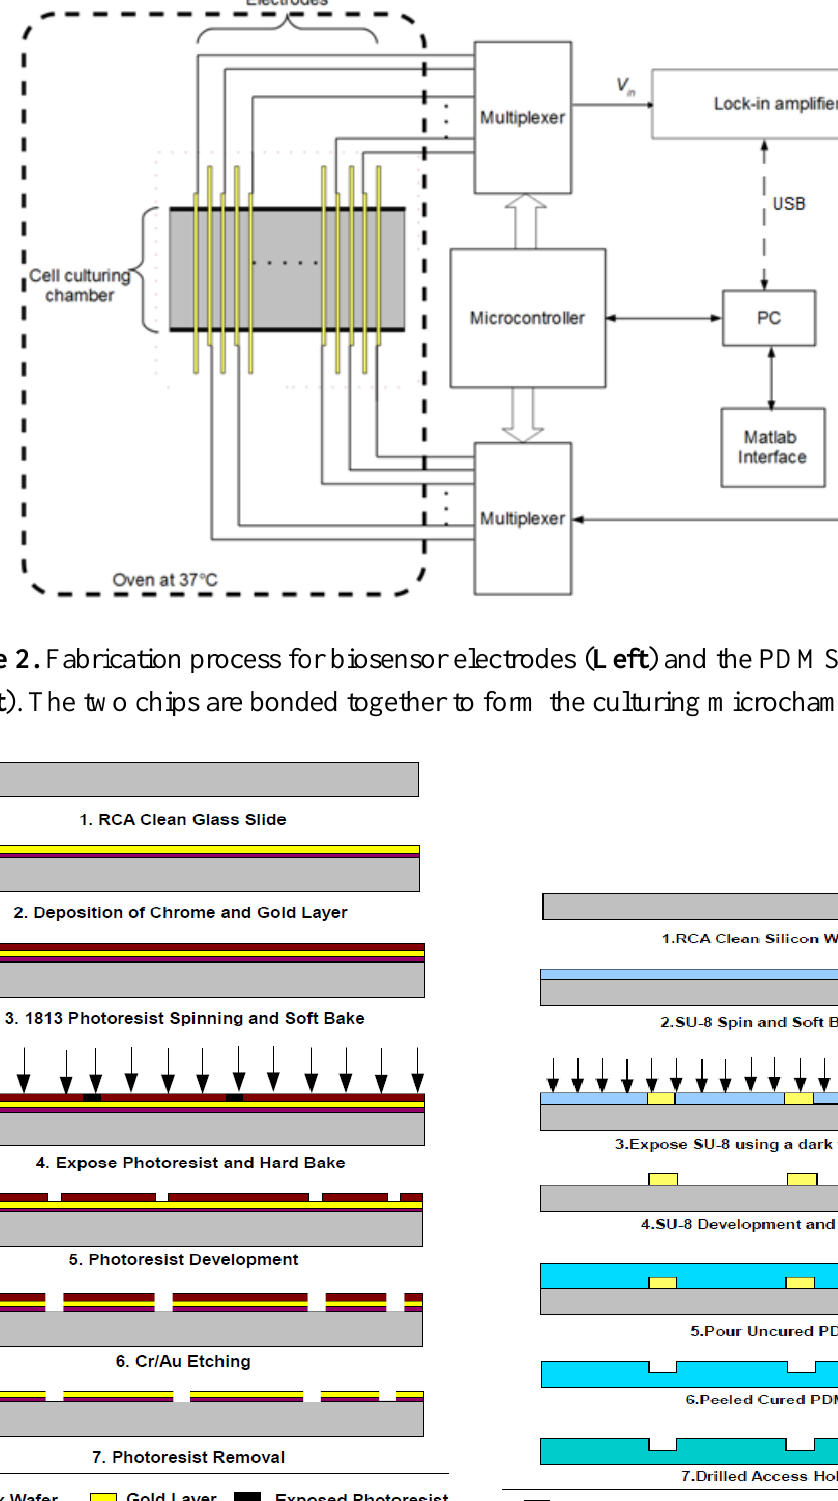
Figure 1. Block diagram of pathogen detection system.